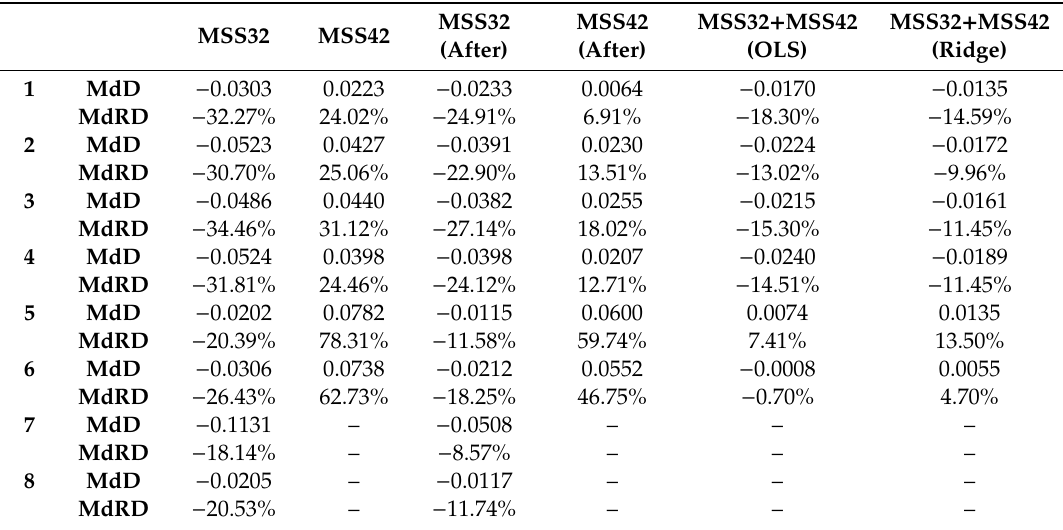
Table 5. Di ff erence measures before and after transformation for eight pairs of the Landsat 5 MSS and TM observations (listed in Table